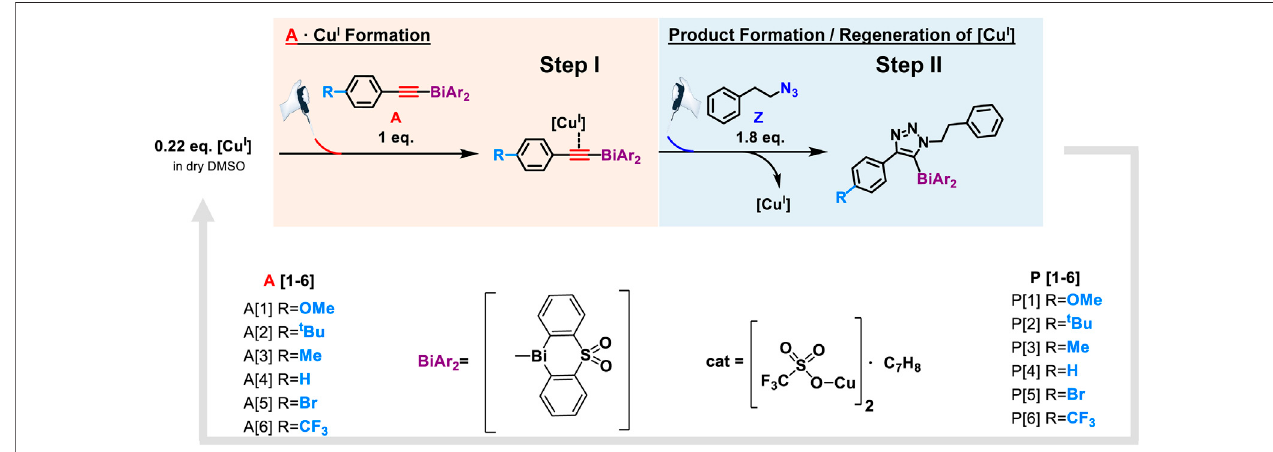
FIGURE 4 | Reaction scheme of kinetic studies of copper(I)-catalyzed reaction of 5-bismuth(III) triazolides formation with cyclic voltammetry technique.